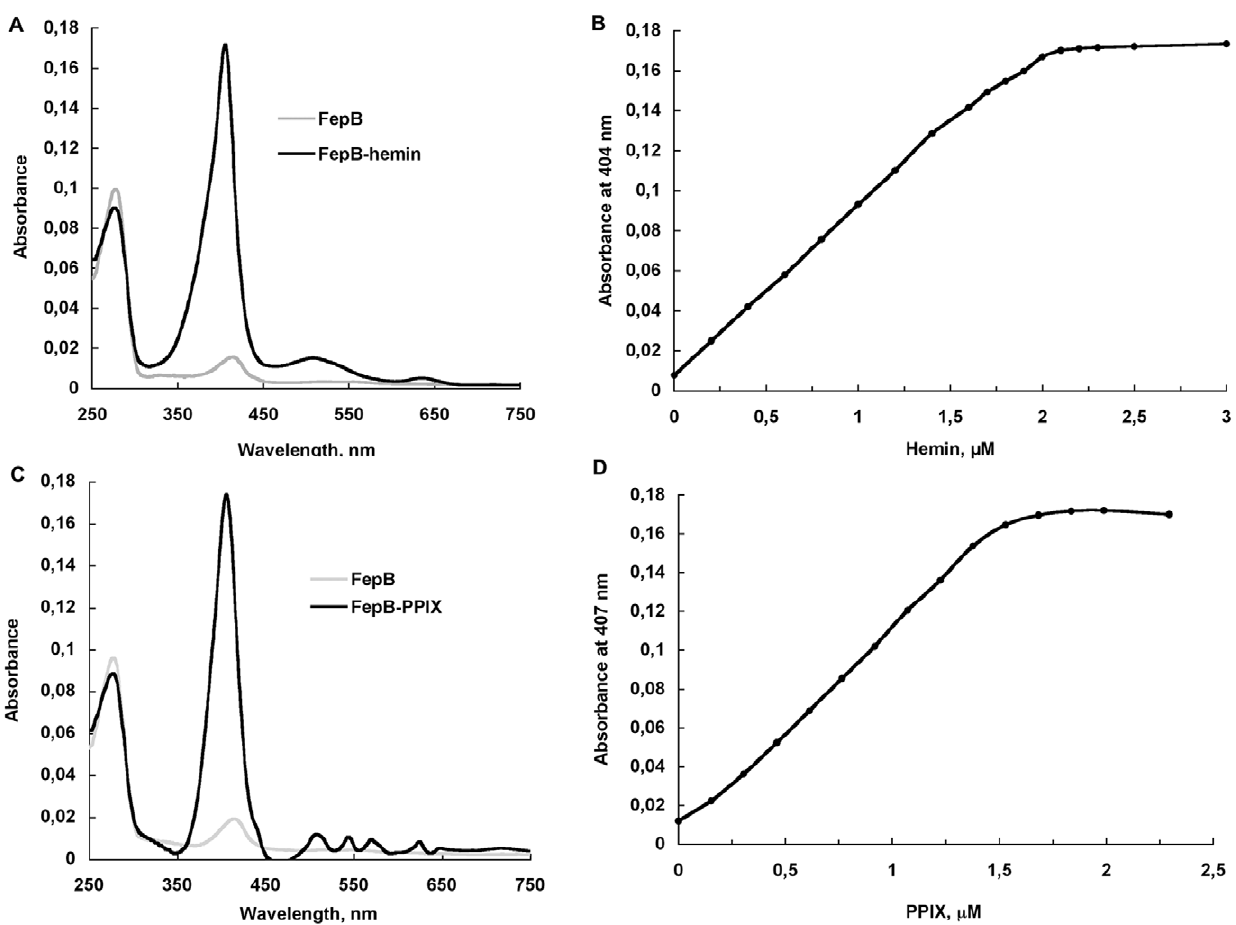
Figure 2. FepB-6His characterization. A and C: UV-visible spectra of apo-FepB (gray line) and FepB-hemin or FepB-PPIX complex of 2.2 mM (black line). B and D: Spectroscopic measure of hemin and PPIX binding to apo-FepB-6His. Aliquots of hemin or PPIX solutions were successively added to 0.5 ml of apo-FepB-6His (2.22 m M). Absorbance at the Soret bands (404 nm and 407 nm for hemin and PPIX respectively) were reported versus porphyrin concentration corrected for absorbance of free porphyrin at the same concentration. Experiments were done 5 times giving similar curves. doi:10.1371/journal.pone.0056529.g002 Production, Stability and Cellular Localization of the Recombinant FepB Protein in E. coli